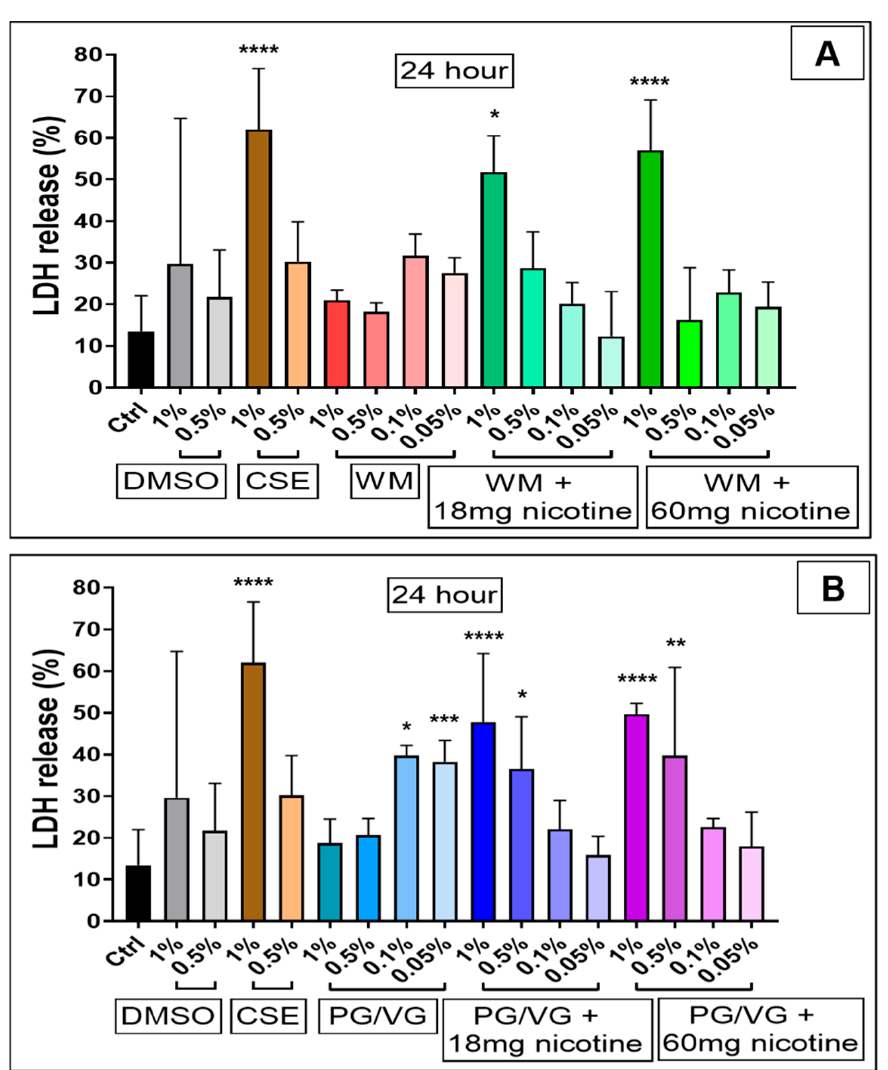
Figure 5. Membrane integrity of BEAS-2B cells following 24 h electronic cigarette aerosol and cigarette smoke exposure: Bronchial epithelial (BEAS-2B) cells were exposed to increasing concentrations (0.05%, 0.1%, 0.5% and 1%) of electronic cigarette condensate from ( A ) watermelon (WM) e-liquid) or ( B ) propylene glycol/vegetable glycerin (PG/VG) ± nicotine or cigarette smoke extract (CSE, 1% and 0.5%) for 24 h. Lactate dehydrogenase (LDH) release was measured from cells treated for 24 h and is presented as the percentage of maximal LDH release. Data are displayed as median with an interquartile range of n = 3–4 independent experiments. Kruskal–Wallis test with Dunn’s multiple comparison test was performed. * p < 0.05; ** p < 0.01; *** p < 0.001; **** p < 0.0001.